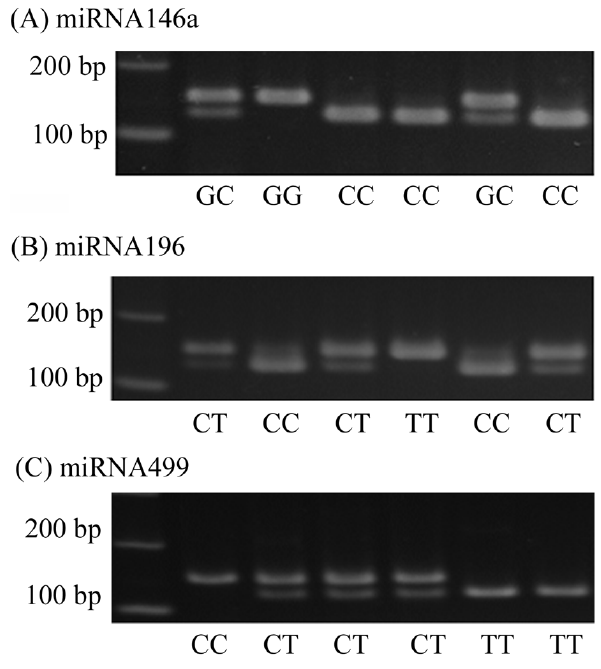
Figure 1. Polymerase chain reaction-restriction fragment length polymorphism of miRNA146a (rs2910164), miRNA196 (rs11614913), miRNA499 (rs3746444) gene. (A) For miRNA146a rs2910164 gene polymorphism, the wild type homozygous alleles (C/C) yielded a 25 and 122-bp products, the heterozygous alleles (C/G) yielded 25-, 122- and 147-bp products, while the mutated